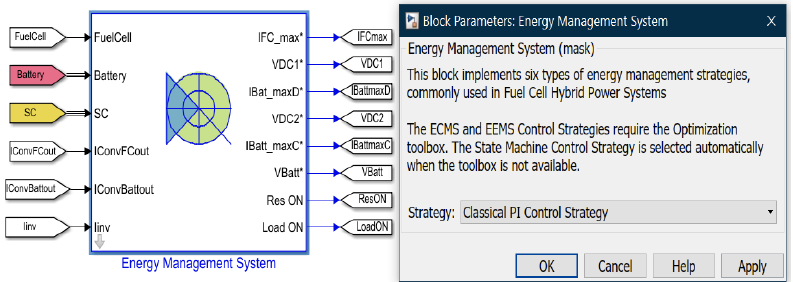
Figure A2. EMS—Classical PI Control Strategy setup.